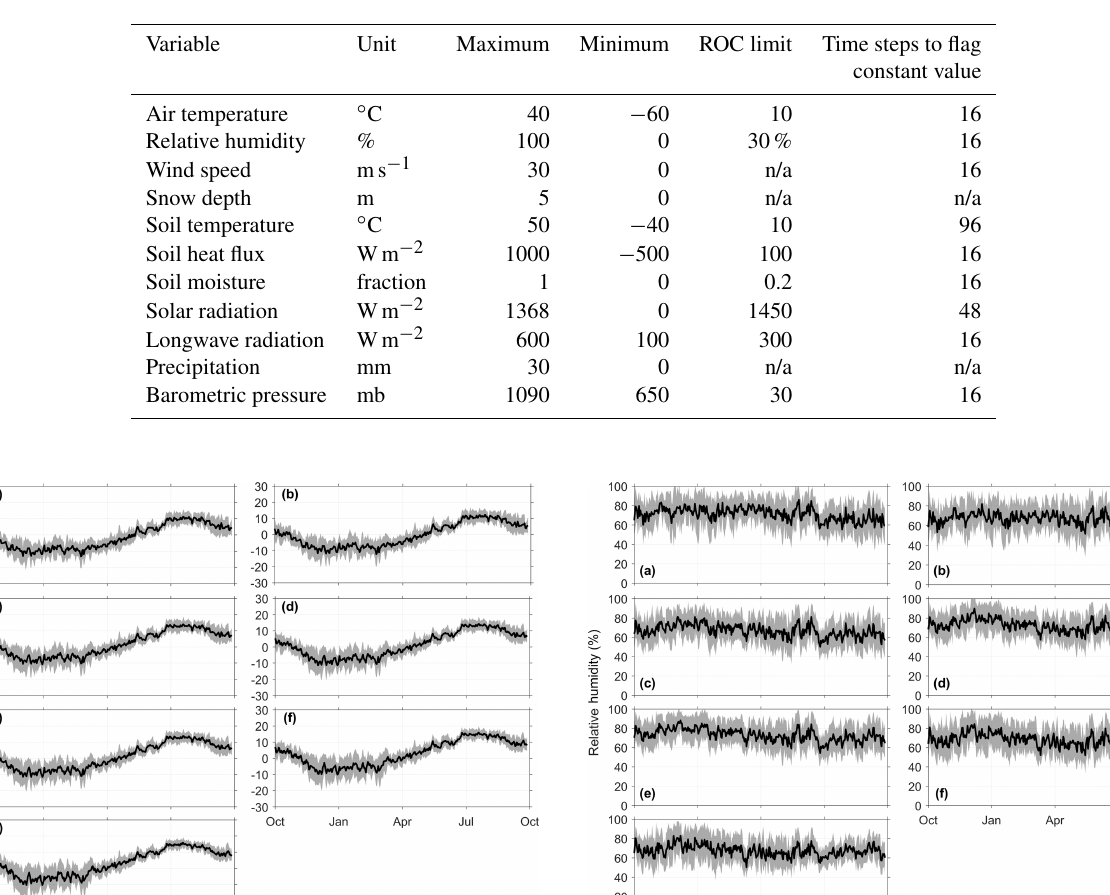
Table 3. Quality-controlled threshold values for 15min hydrometeorological variables for current stations in MCRB; ROC and n/a denote rate of change and not applicable, respectively.